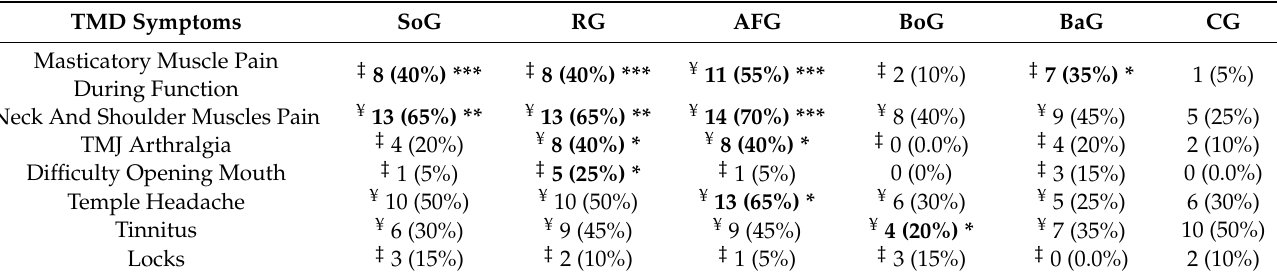
Table 4. TMD symptoms: comparison between different sports and